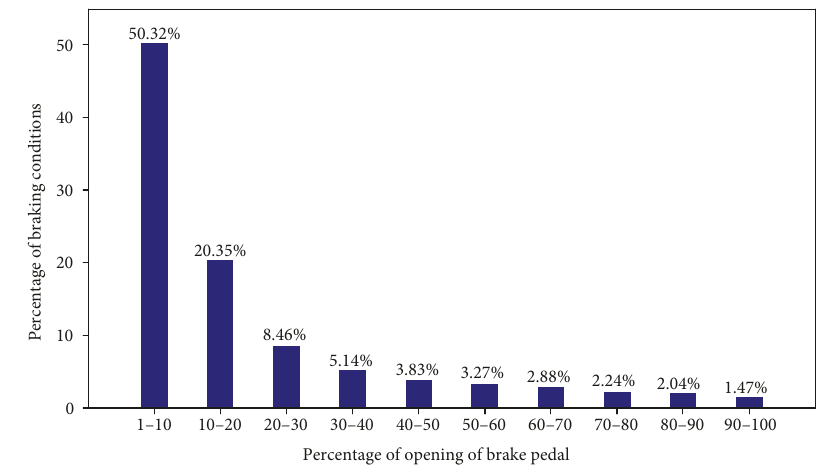
Figure 14: Statistical schematic of brake pedal opening.